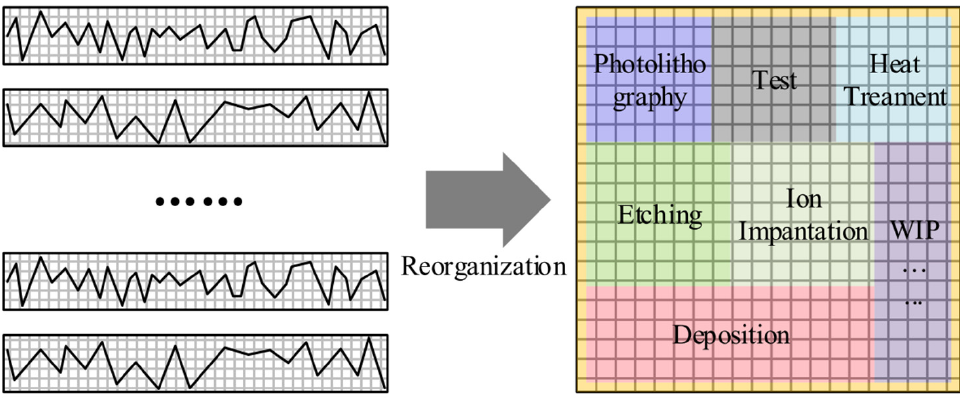
Figure 3. Reorganize the time series data to a feature map through the block splicing of different processing areas.